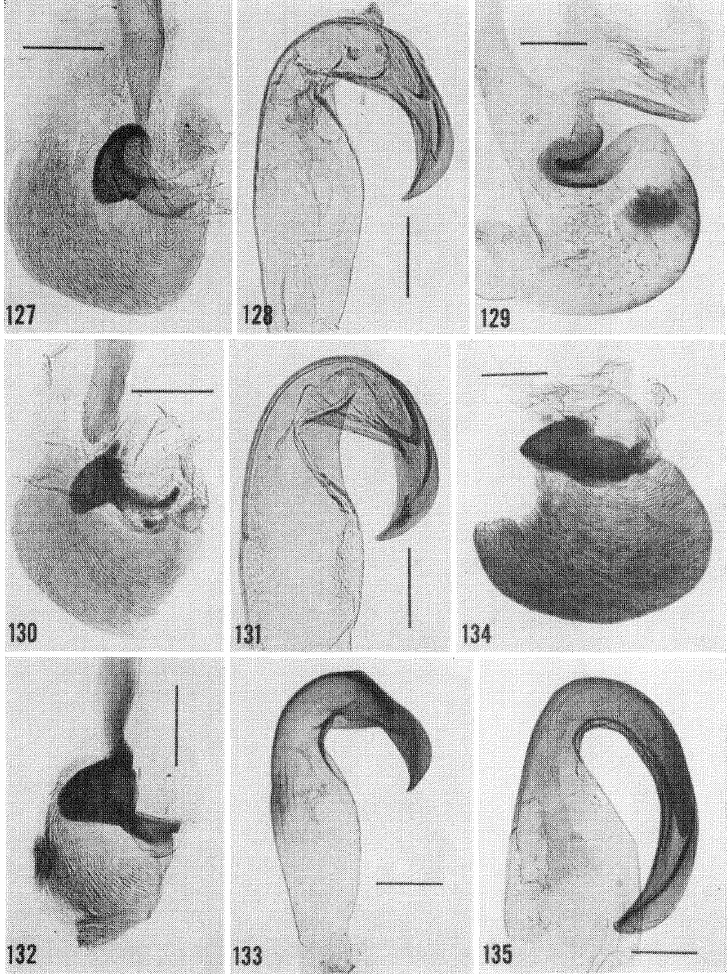
Figs. 127-135. Cockroach male genitalia. 127-133. EpilamIra burmei- steri). 127-129. (26 MCZ). Cuba (labeled E. caraibea S. and Z., which is a synonym of burmeisteri).